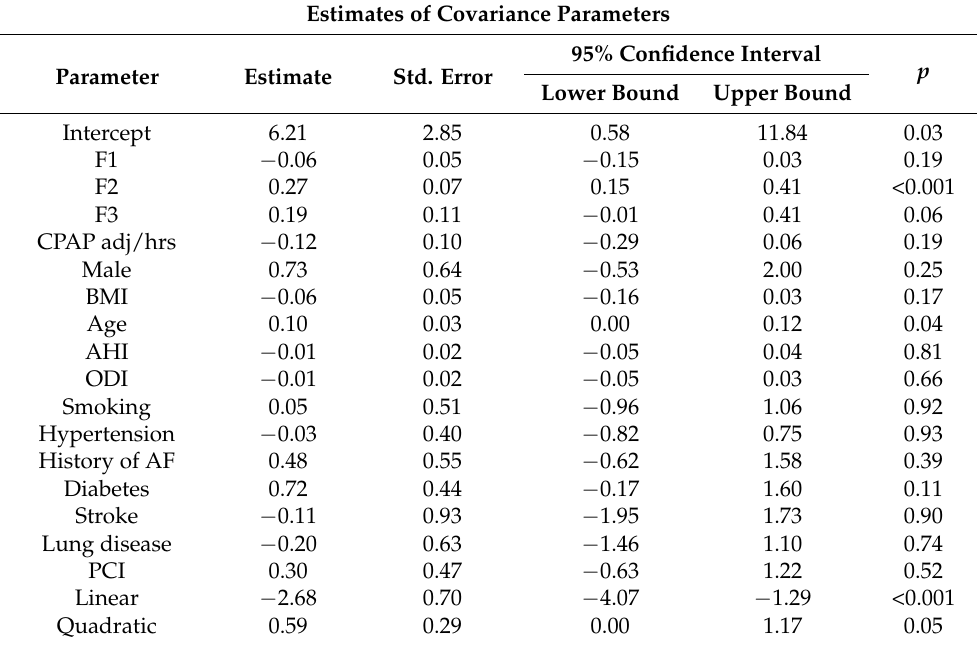
Table 6. The fixed effect of between-subjects predictors in the model.